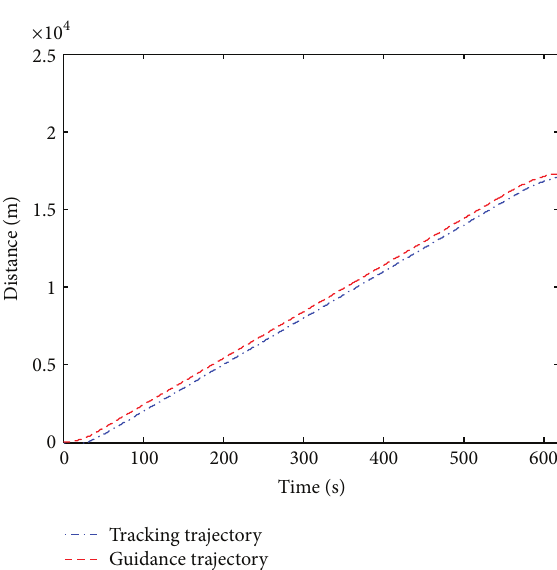
Figure 5: Train distance tracking curve (single model PFC).